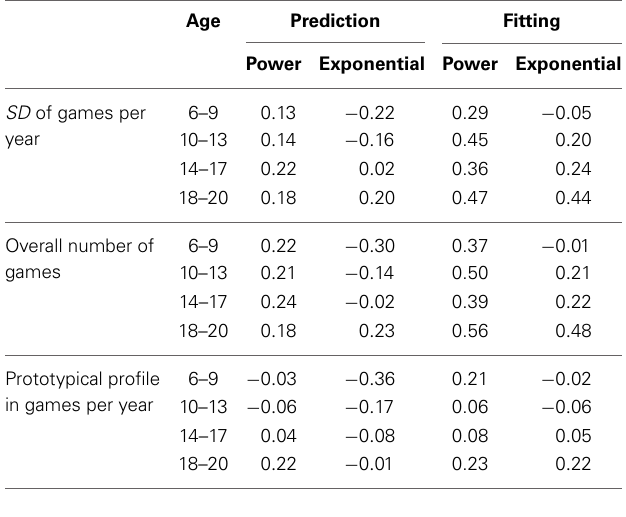
FIGURE 6 | Average time course in tournament performance for players starting at 6–20 years of age grouped by birth